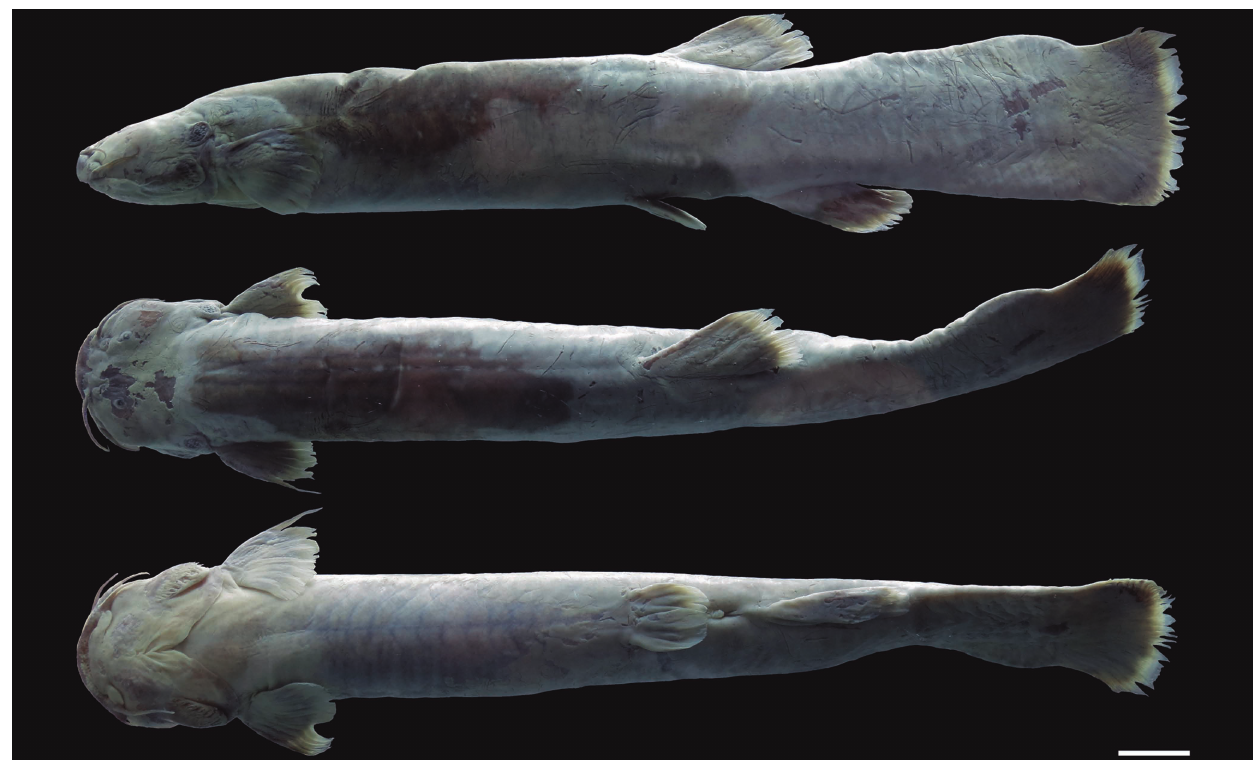
Fig. 4. Trichomycterus steindachneri , holotype, MPUJ 4191, 143.5 mm SL; Colombia, Cundinamarca, Ubaque, vereda Pueblo Nuevo, quebrada El Charco, tributary of quebrada Santa Bárbara, río El Palmar system, río Orinoco basin, 04°31’10.3”N 73°58’44.6”W, 2700 m. Scale bar = 1 cm.